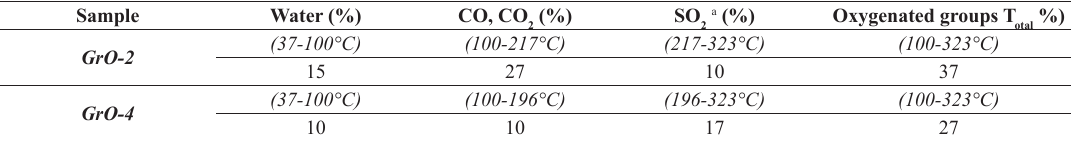
Table 1. Thermal events measured for GrO-2 and GrO-4 measured using TGA. Sample